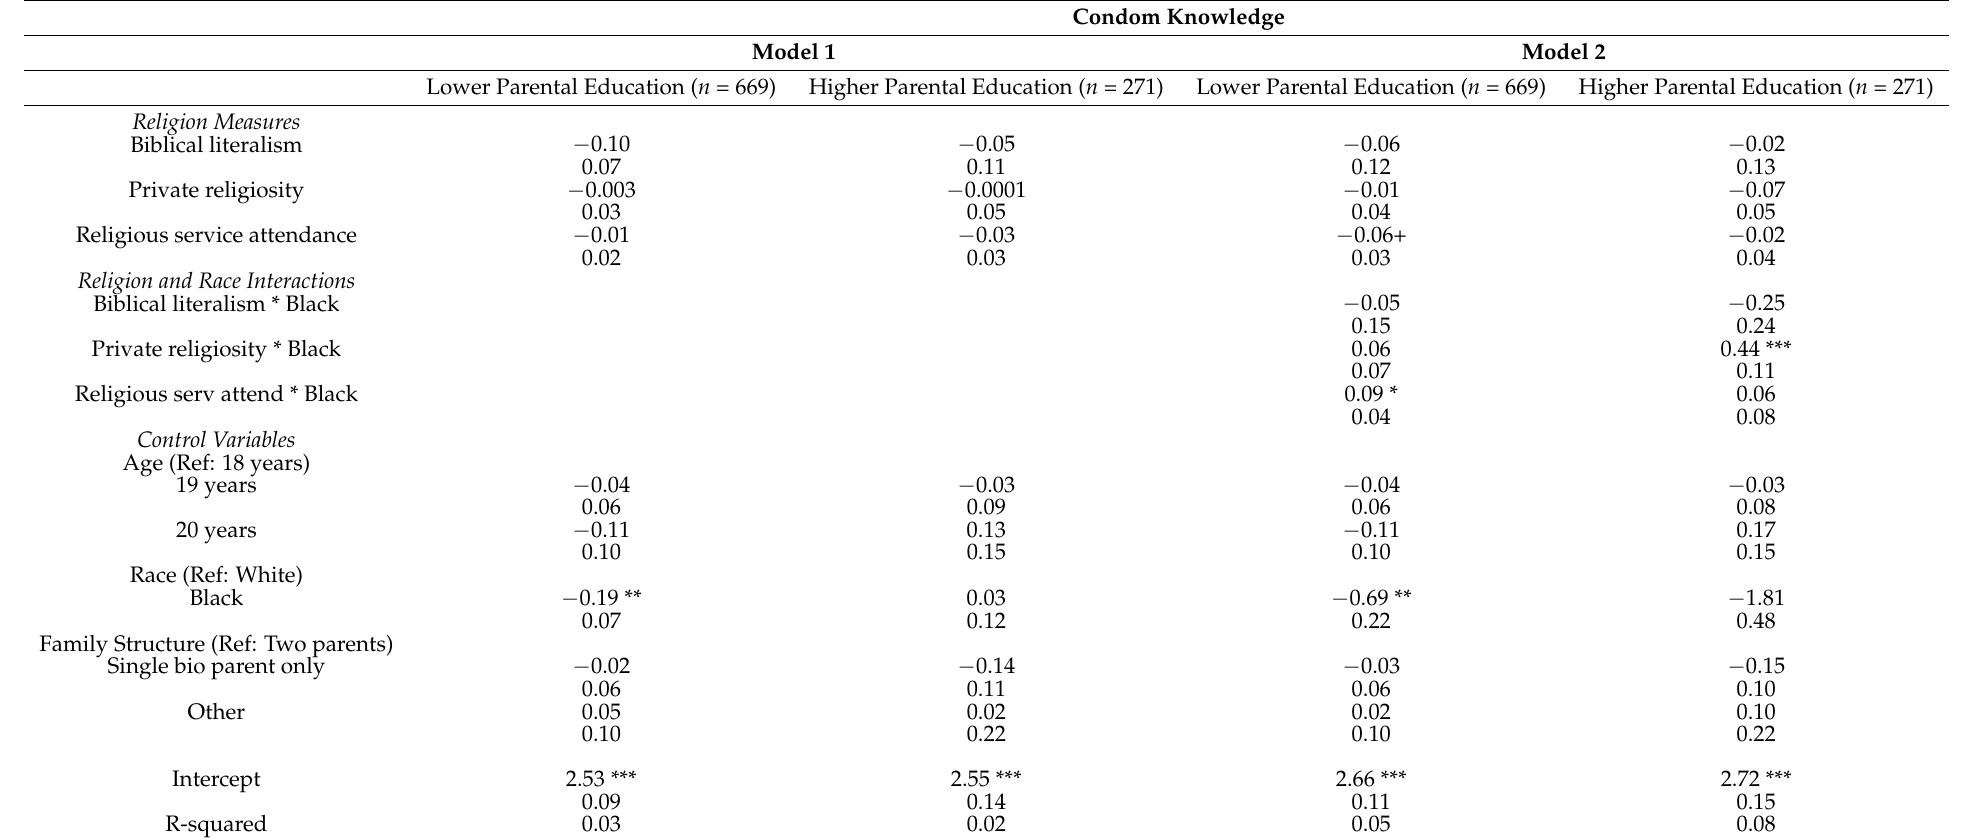
Table 4. OLS Regression Models of Relationships between Religion Measures and Condom Knowledge, Separate by Parent Education, and Interactions with Race